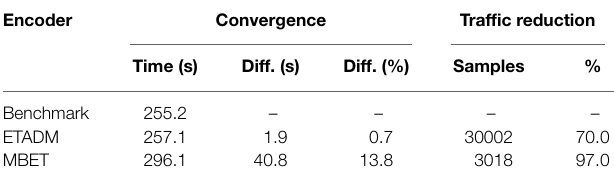
TABLE 3 | Traffic reduction and convergence comparison